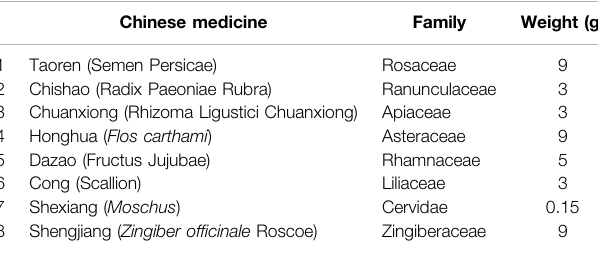
TABLE 1 | The composition of